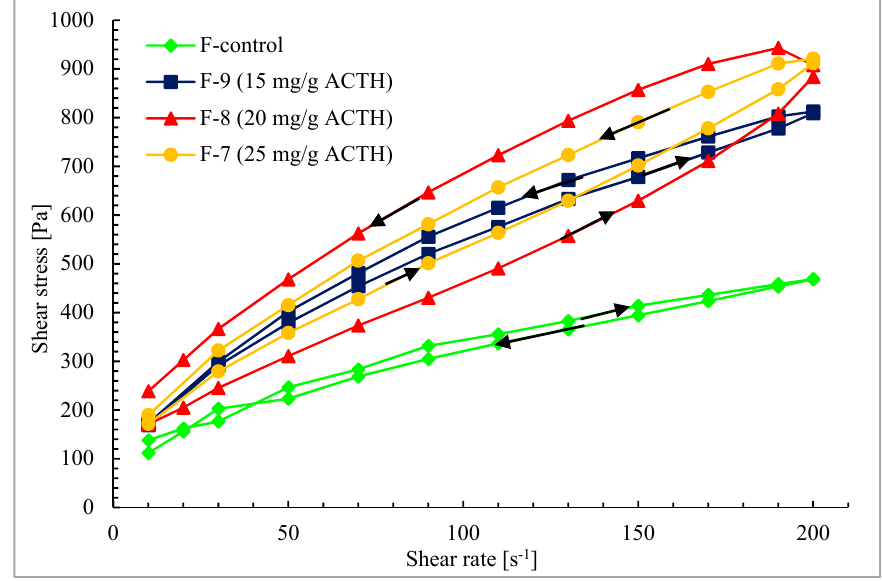
Figure 6. Hysteresis loops for formulation F-7–F-9 and control ointment-F-control.